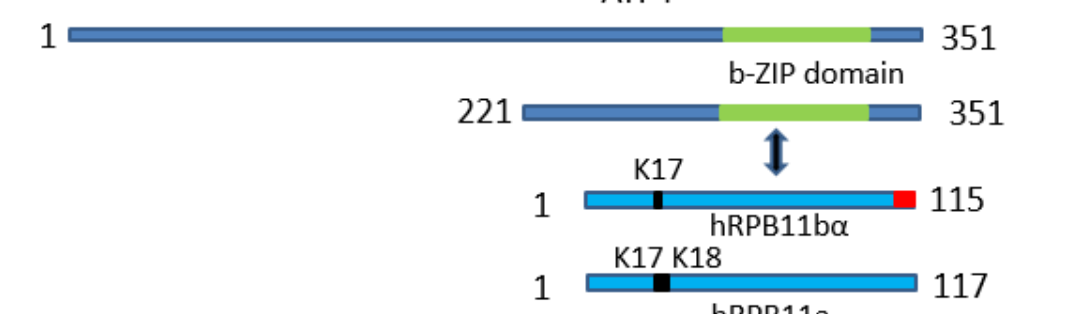
Figure 3. Schematic representation of the uncovered protein-protein interaction: The minor subunit of Homo sapiens RNA polymerase II hRPB11bα specifically interacts with transcription factor ATF4 through its C-terminal b-Zip domain.